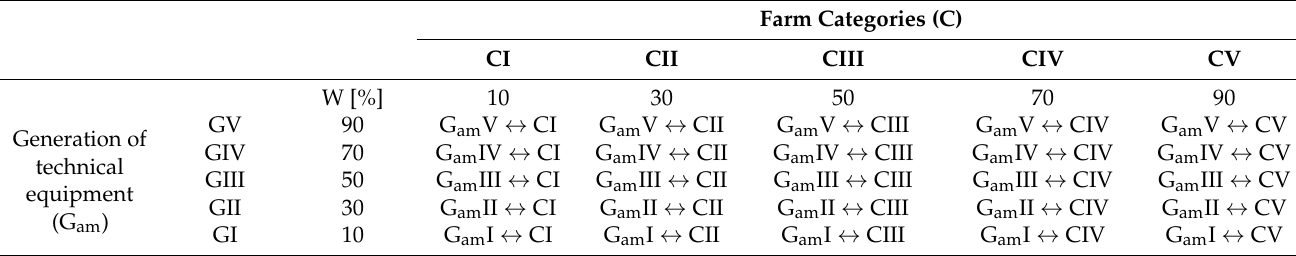
Table 3. Matrix of options for linking/adjusting the generation of agricultural technical equipment (G am ) with farm categories